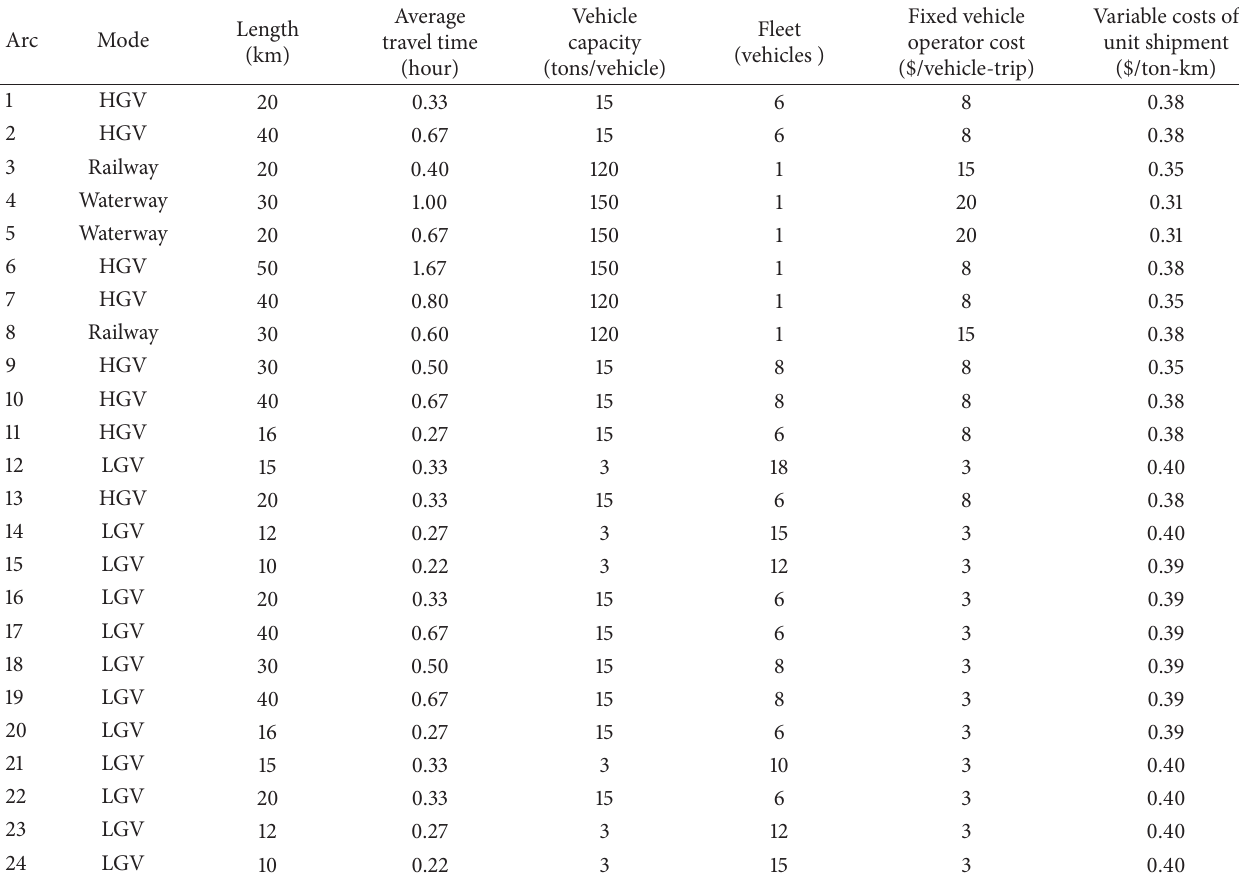
Table 2: The basic input data for the logistics service network.